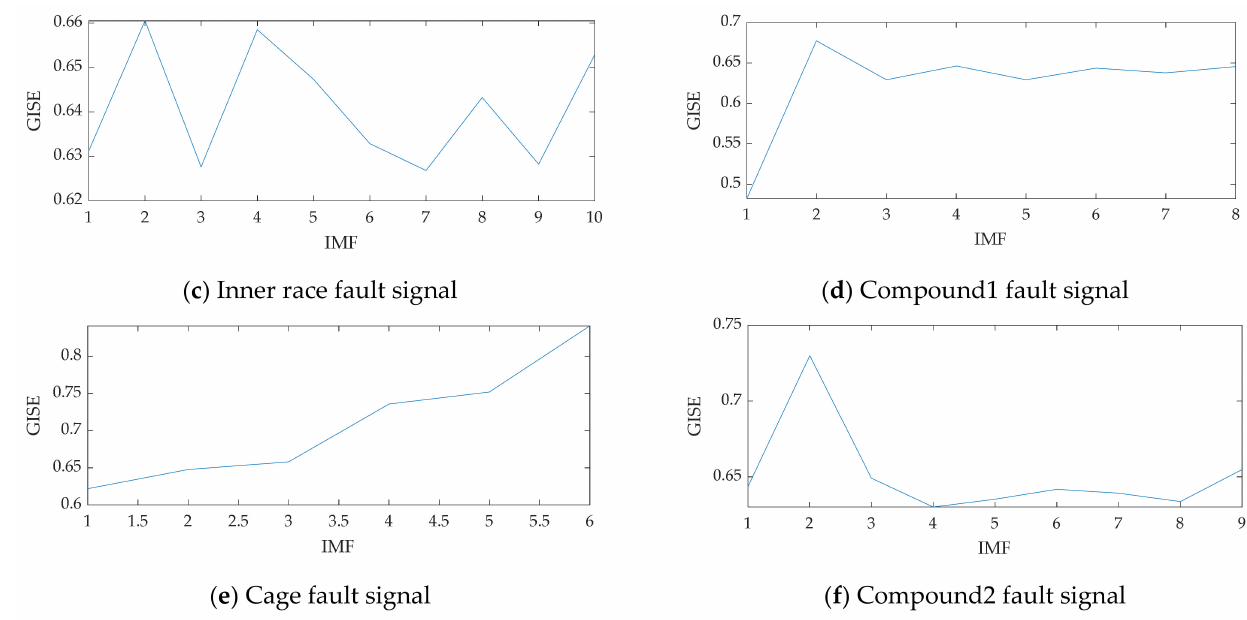
Figure 8. Comparison of GISE values of various components.